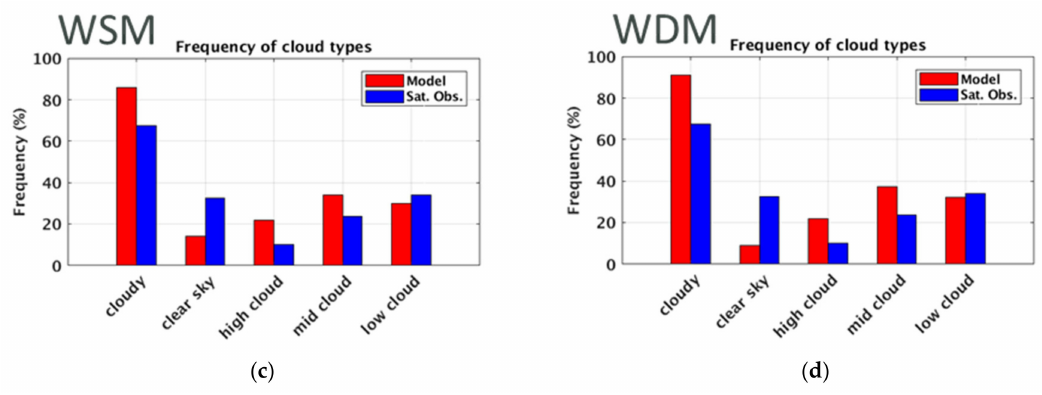
Figure 9. Frequency of cloud type. Valid on June 2 at 1200 UTC and simulated with ( a ) GCE, ( b ) MOR, ( c ) WSM, and ( d ) WDM.